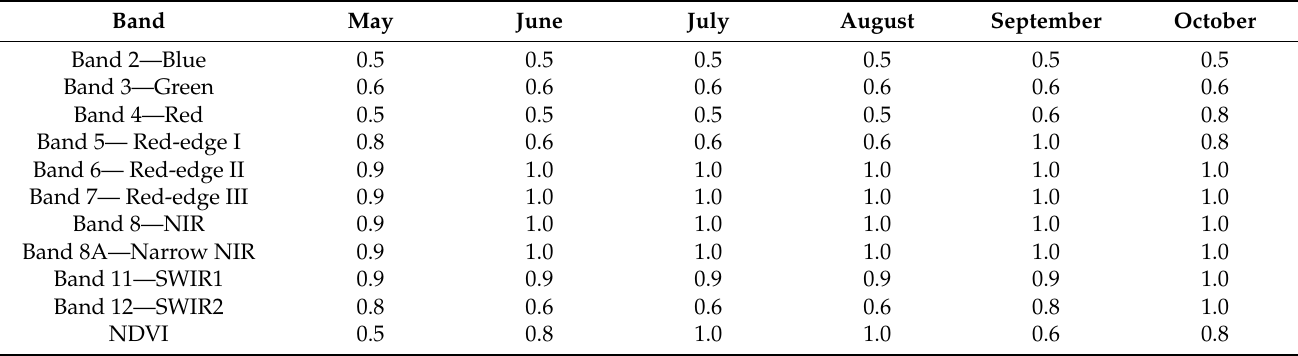
Table 4. Weights of spectral